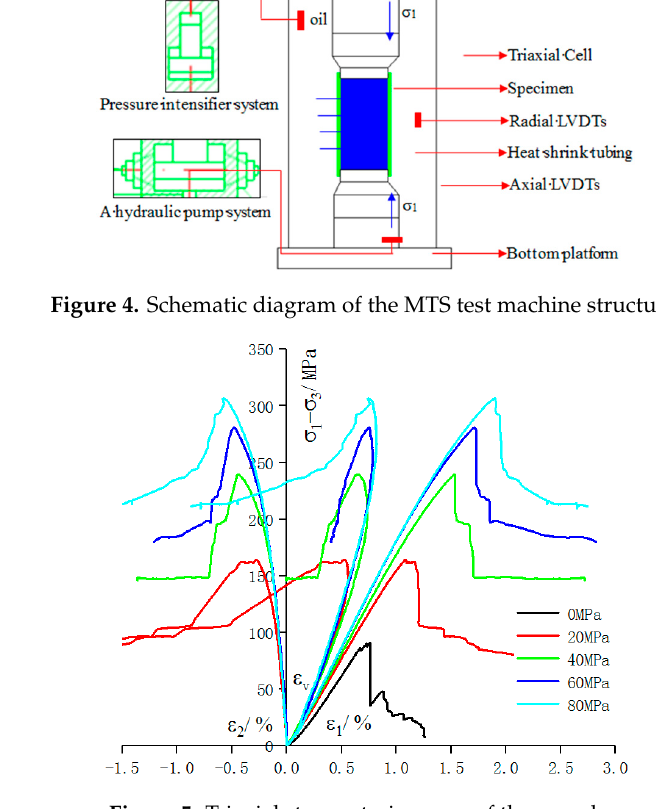
Figure 5. Triaxial stress–strain curve of the samples.